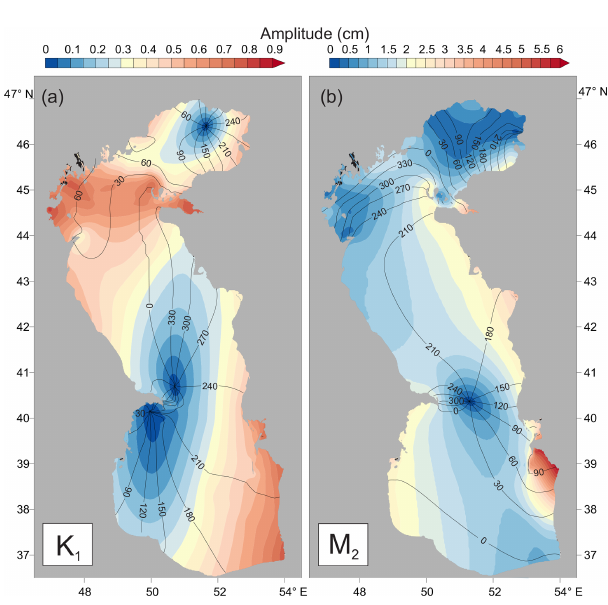
Figure 3. Tidal maps of the co-amplitudes (cm) (shaded) and co- phase lags (degrees, UTC) (solid lines) for the (a) K 1 and (b) M 2 tidal